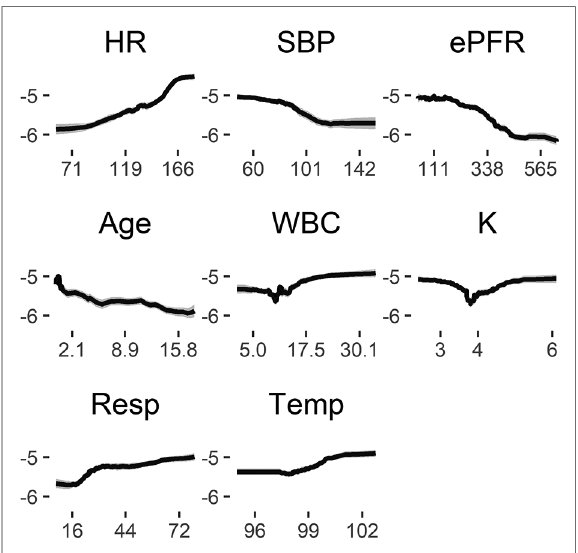
FIGURE 3 Risk pro fi les for exemplary features in the random forest model. These are marginal risk pro fi les that average out dependence on other features, such as the dependence of heart rate on age. The (natural) log odds of unplanned intubation in the next 12 h (ordinate) is shown as a function of the value of each measured variable (abscissa) holding all other features at their median values. Lower blood pressure, for example, is associated with increased risk for unplanned intubation independent of changes in any other